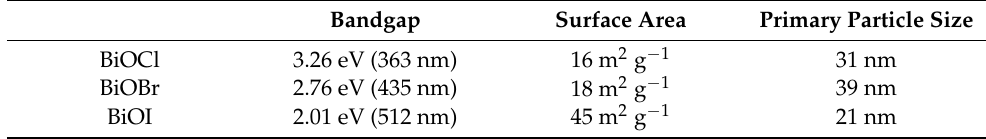
Figure 1. UV–Vis DRS spectra ( a ) (shadow indicates the emission range of LED (violet: UV-LED, red: Vis-LED)), Kubelka Munk Curves ( b ), and XRD patterns ( c ) of BiOCl, BiOBr, and BiOI. Table 1. The specific surface areas and bandgap values of the photocatalysts.